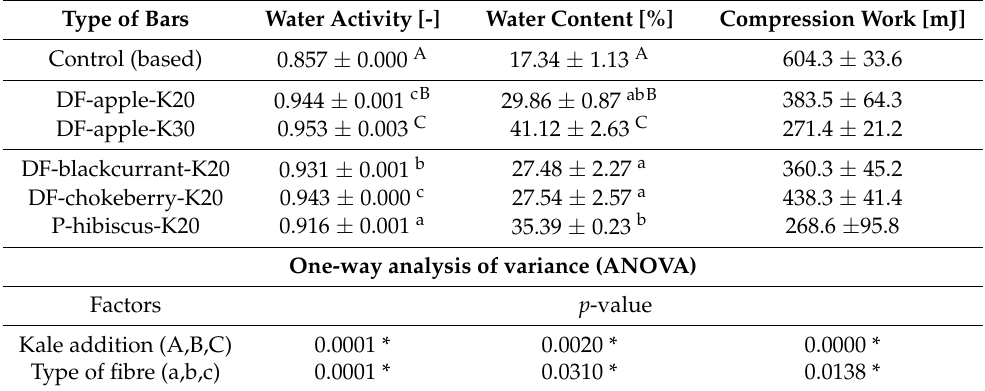
Table 2. The effect of kale and fibre preparation on water content, water activity (Aw), and compres- sion force (Fmax) and work (W) in multigrain